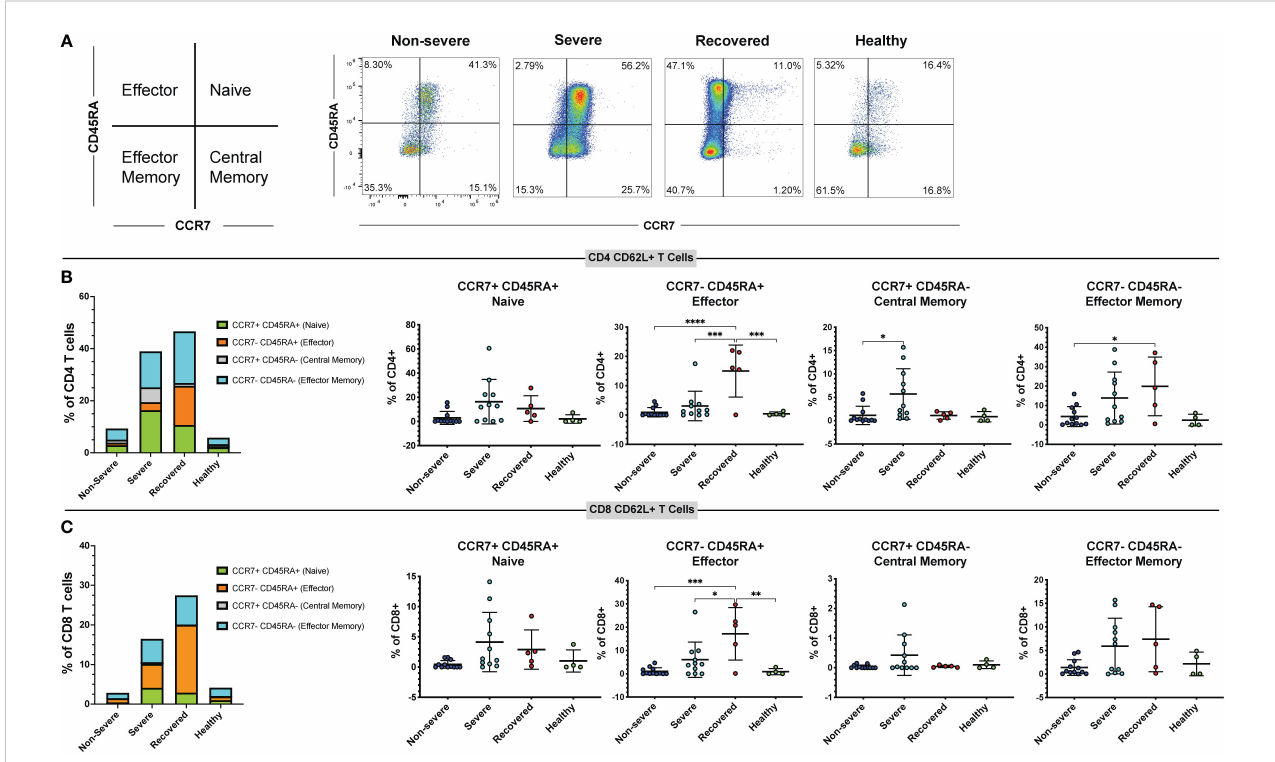
FIGURE 3 Immunological memory phenotyping of CD62L+ T cells. Expression of CCR7 and CD45RA on CD62L+ CD4+ and CD8+ T cells (viable, CD14-, CD56-, CD19-, CD3+, CD4+ or CD8+ cells) in non-severe and severe COVID-19 patients, recovered COVID-19 patients, and healthy controls was assessed by fl ow cytometry. (A) Representative diagram and fl ow cytometry plots showing naïve CD4+ CD62L+ T cells (CCR7+ CD45RA+), central memory CD4+ CD62L+ T cells (CCR7+ CD45RA-), effector memory CD4+ CD62L+ T cells (CCR7- CD45RA-), and effector CD4+ CD62L+ T cells (CCR7- CD45RA+); (B) percentages of CD62L+ naïve, effector, central memory, and effector memory cells within the CD4+ T cell population; (C) percentages of CD62L+ naïve, effector, central memory, and effector memory cells within the CD8+ T cell population. *p<0.05, **p<0.01, ***p<0.001 one-way ANOVA with multiple comparisons